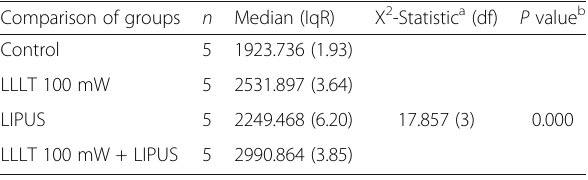
Table 2 Comparison of median for the tooth movement measurements among study groups at day 21